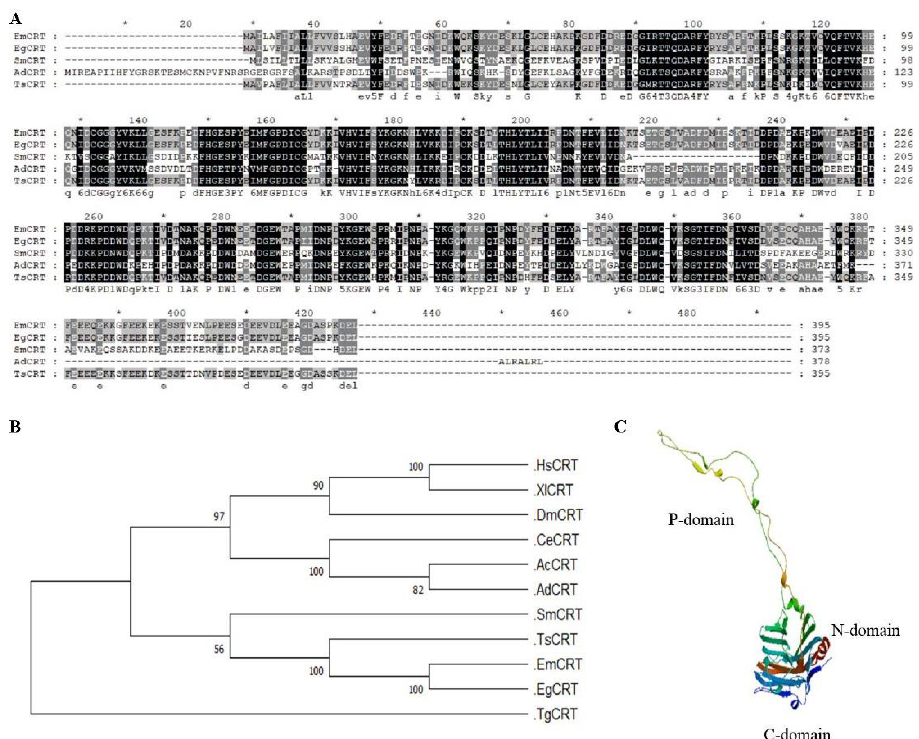
Figure 1. Amino acid sequence analysis and predicted three-dimensional structure of Em CRT. ( A ) Amino acid sequence alignment of Em CRT with its homologs from Echinococcus granulosus (EgCRT), Schistosoma mansoni (SmCRT), Taenia solium (TsCRT) and Ancylostoma duodenale (AdCRT) using the GeneDoc software. Numbers on the right refer to the last amino acid in each corresponding organism. Residues with dark shading indicate the same amino acids. Grey shading represents 80 – 90% similarity and light grey represents 60 – 70% similarity. ( B ) Phylogenetic analysis of the Em CRT and its homologues. Phylogenetic tree was generated with MEGA 6.0 by the neighbor-joining method (bootstrap = 1000). The numbers on the branches represent bootstrap values. Homo sapiens (HsCRT), Xenopus laevis (XlCRT), Drosophila melanogaster (DmCRT), Caenorhabditis elegans (CeCRT), Angiostrongylus cantonensis (AcCRT) and Trypanosoma grayi (TgCRT). ( C ) Modeled 3D structure of Em CRT.